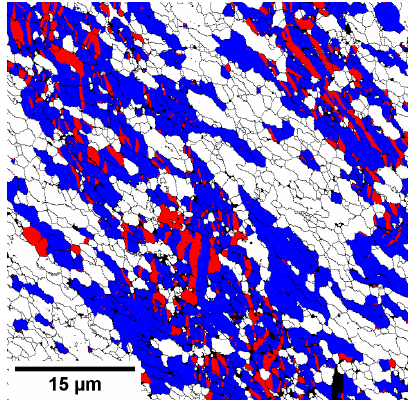
Figure 9. Parent/twin map calculated from EBSD, measured on a longitudinal section of the 8P sample, deformed in compression up to 4% of plastic deformation. Loading direction is horizontal. (Blue color corresponds to parent grains, red color corresponds to twins.)